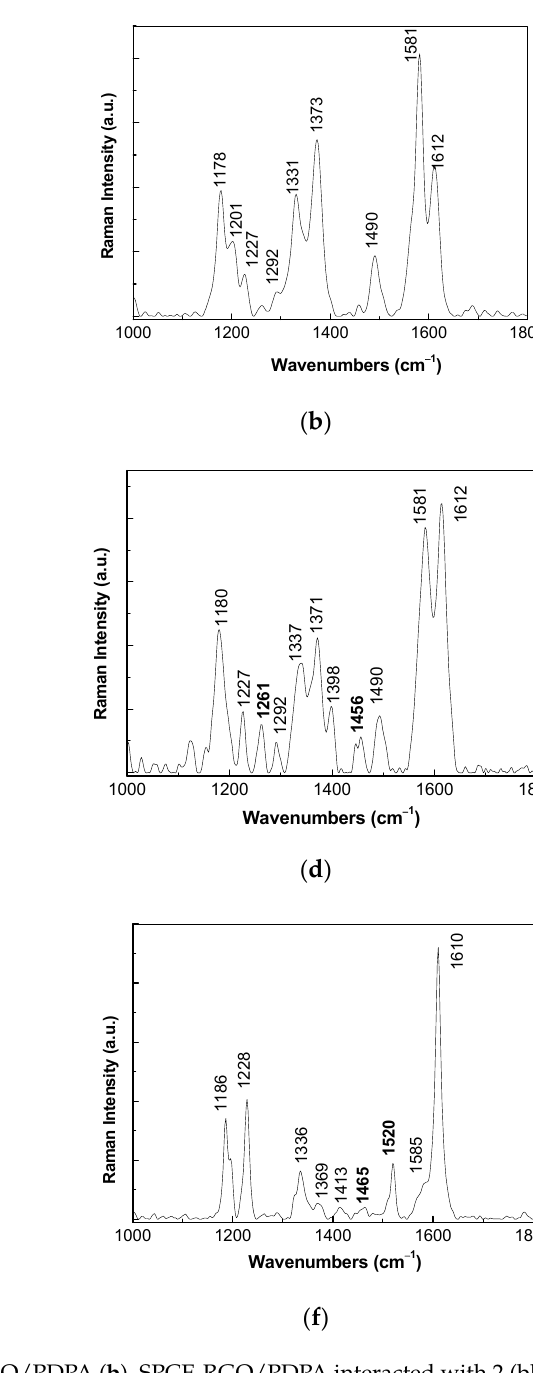
Figure 2. The Raman spectra of SPCE-RGO ( a ), SPCE-RGO/PDPA ( b ), SPCE-RGO/PDPA interacted with 2 (blue curve) and 4 mg mL − 1 (magenta curve) PDITC in ethanol ( c ), and after the interaction of SPCE-RGO/PDPA/PDITC with protein G ( d ), anti-epidermal growth factor receptor (EGFR) ( e ) and EGFR ( f ). In this last case, we observe that: